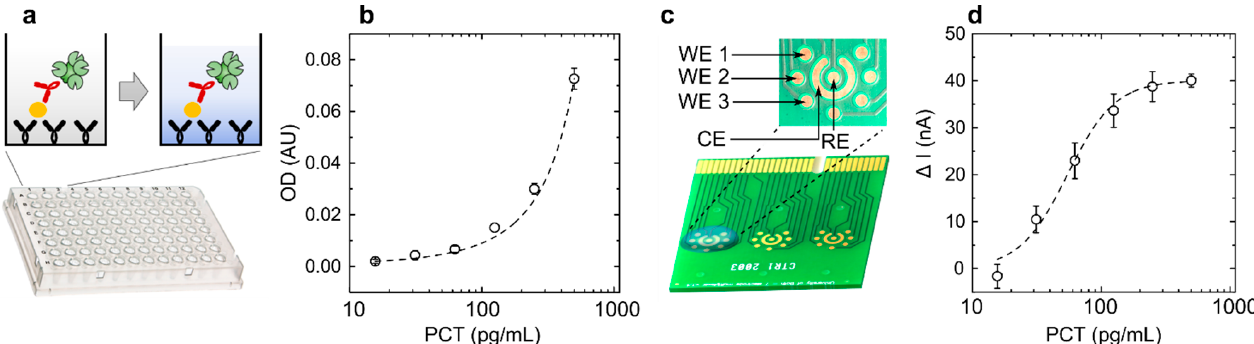
Figure 5. Optical and electrochemical quantification of PCT ELISA assay. ( a ) Conceptual representation of the ELISA assay performed in a 96-well plate, where the addition of TMB is seen as a colour change. ( b ) Optical detection of the colour change ( N = 3). ( c ) Electrochemical set-up with gold PCB working electrodes (WE 1, 2, and 3) and shared counter (CE) and reference (RE) electrode. ( d ) Electrochemical detection of TMB using chronoamperometry ( N = 3).